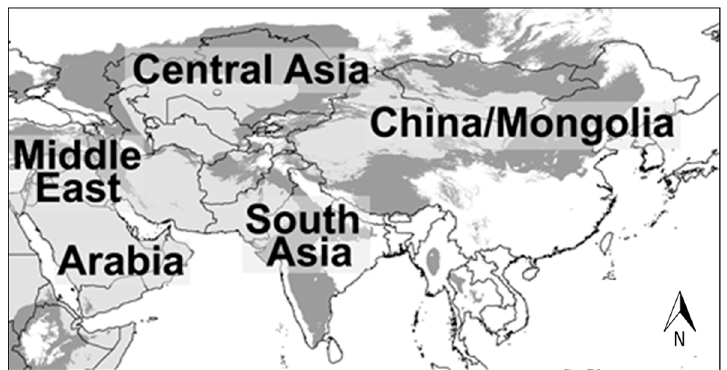
Figure 1. Asian drylands including West (Middle East, Arabia), South, Central and East Asia. Gray = arid (<250 mm annual precipitation), black = semi-arid (<500 mm annual precipitation [13]. Dryland percentage varies from ~99% in most of West Asia, to 80% in Pakistan and Mongolia, 69% in India and 52% in China.